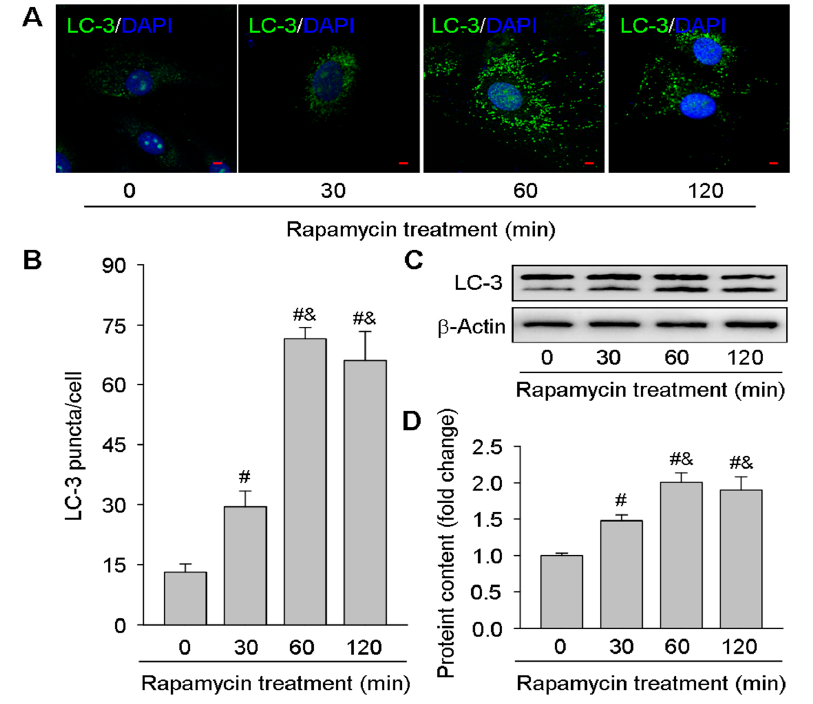
Figure 4. Effects of rapamycin on LC-3II expressions in luteal cells cultured in vitro. Luteal cells were isolated from rat ovaries on day 16 of pregnancy and then cultured with rapamycin (100 nM) for 0, 30, 60, and 120 min: ( A ) representative immunofluorescent pictures depicting the protein levels of LC-3; ( B ) summarized puncta of LC-3 immunofluorescence; ( C ) representative western blotting analyses depicting the protein levels of LC-3; ( D ) summarized intensities of LC-3II blots normalized to the control. Each value represents the mean ± SE, n = 6. ANOVA was used to analyze the data. #: p < 0.05 vs. p on day 10, &: p < 0.05 vs. p on day 16. Rapamycin: an mTOR inhibitor, LC-3: an autophagy marker protein. Scale bar = 20 µ